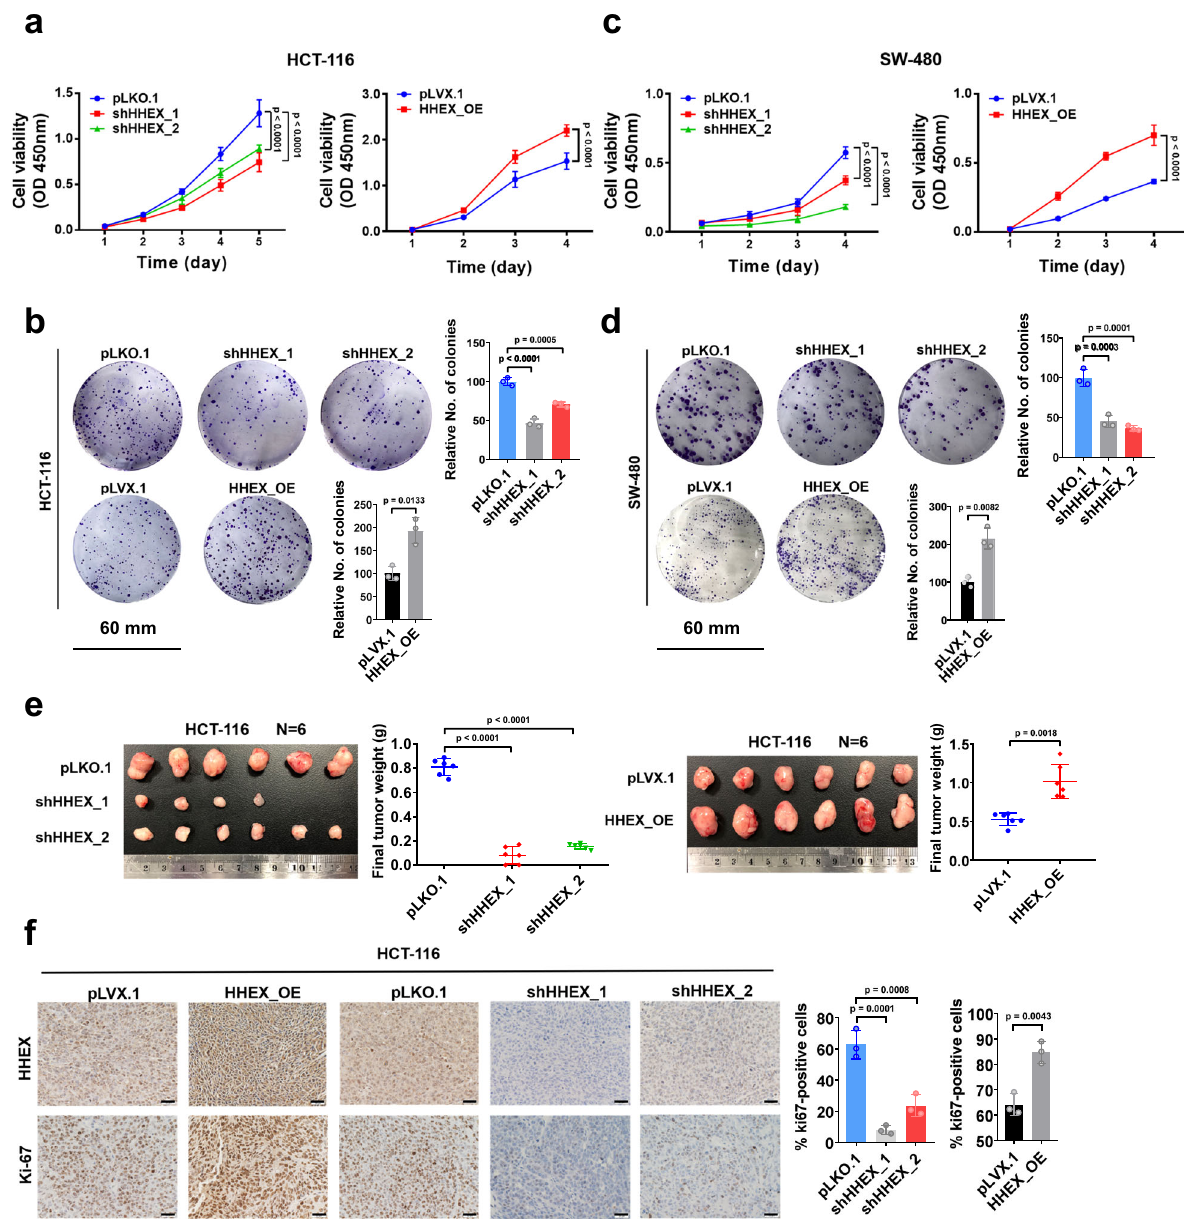
Fig. 3 | HHEX enhances tumor growth in CRC cells. a , c CCK-8 assays of the proliferation of HCT-116 ( a ) and SW-480 ( c ) cells with HHEX knockdown or over- expression. b , d Colonyformationassaysandstatisticalanalysisoftheproliferation ofHCT-116( b )andSW-480( d )cellswith HHEX knockdownoroverexpression.Scale bars, 60mm. e Representative images of xenograft tumors derived from 1×10 6 HCT-116 cells with HHEX knockdown or overexpression ( n =6). Empty means that no tumors formed. The weights of the xenograft tumors were measured and sta- tistically analyzed. f Representative images of IHC staining of HHEX and the pro- liferation marker Ki67 in xenograft tumors derived from HCT-116 cells with HHEX